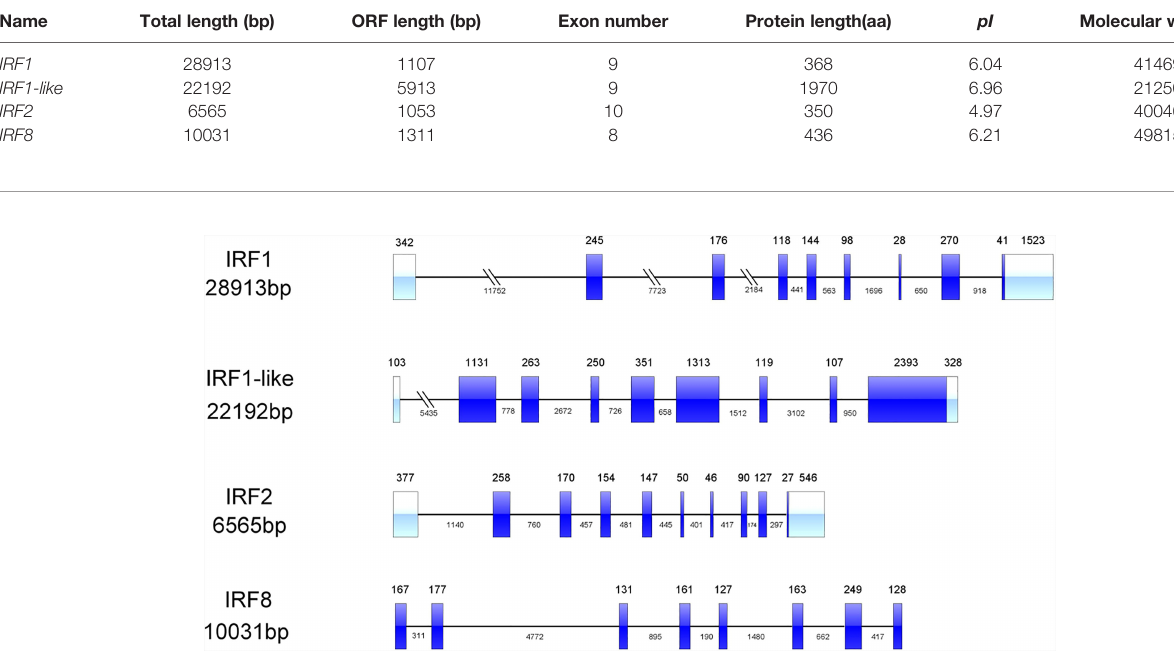
TABLE 2 | Summary of sequence features of CfIRF genes.